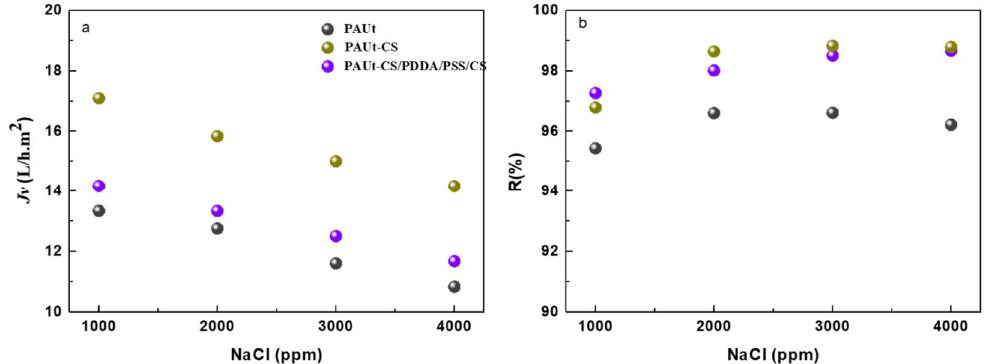
Figure 8. The reverse osmosis membrane performance under different salt concentration. ( a ) water flux and ( b ) salt rejection. Testing conditions: Applied pressure is 1.55 MPa with 1000–4000 ppm NaCl as feed solution at 25.0 ± 2.0 °C.